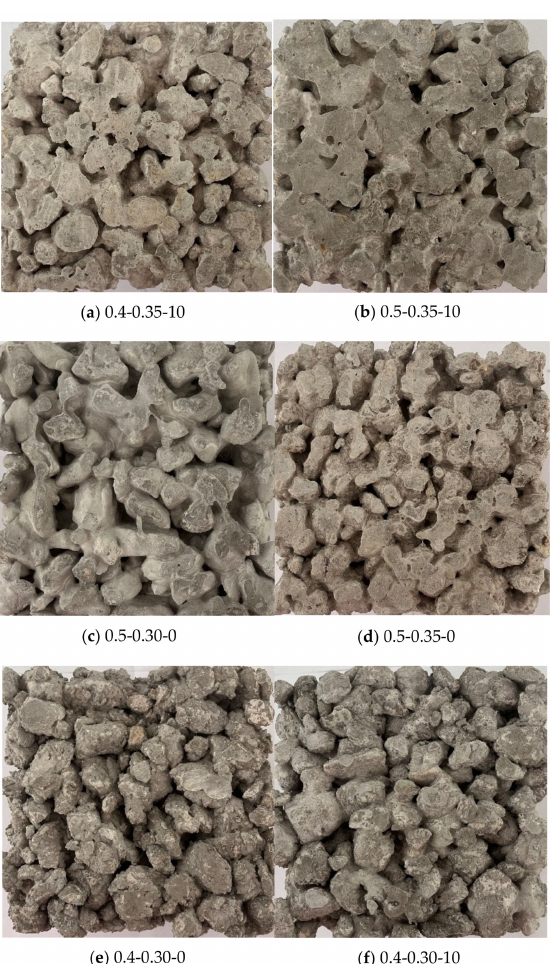
Figure 10. Photographs of underside of pervious